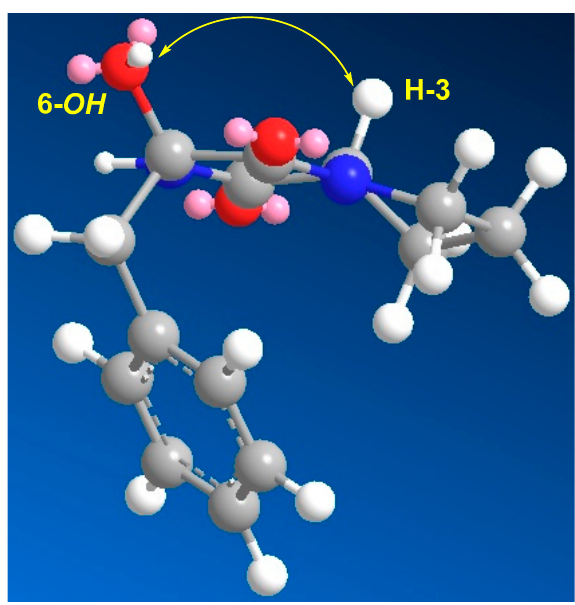
Figure 3. MM2 energy-minimized drawing of 2 showing an important NOE correlation.